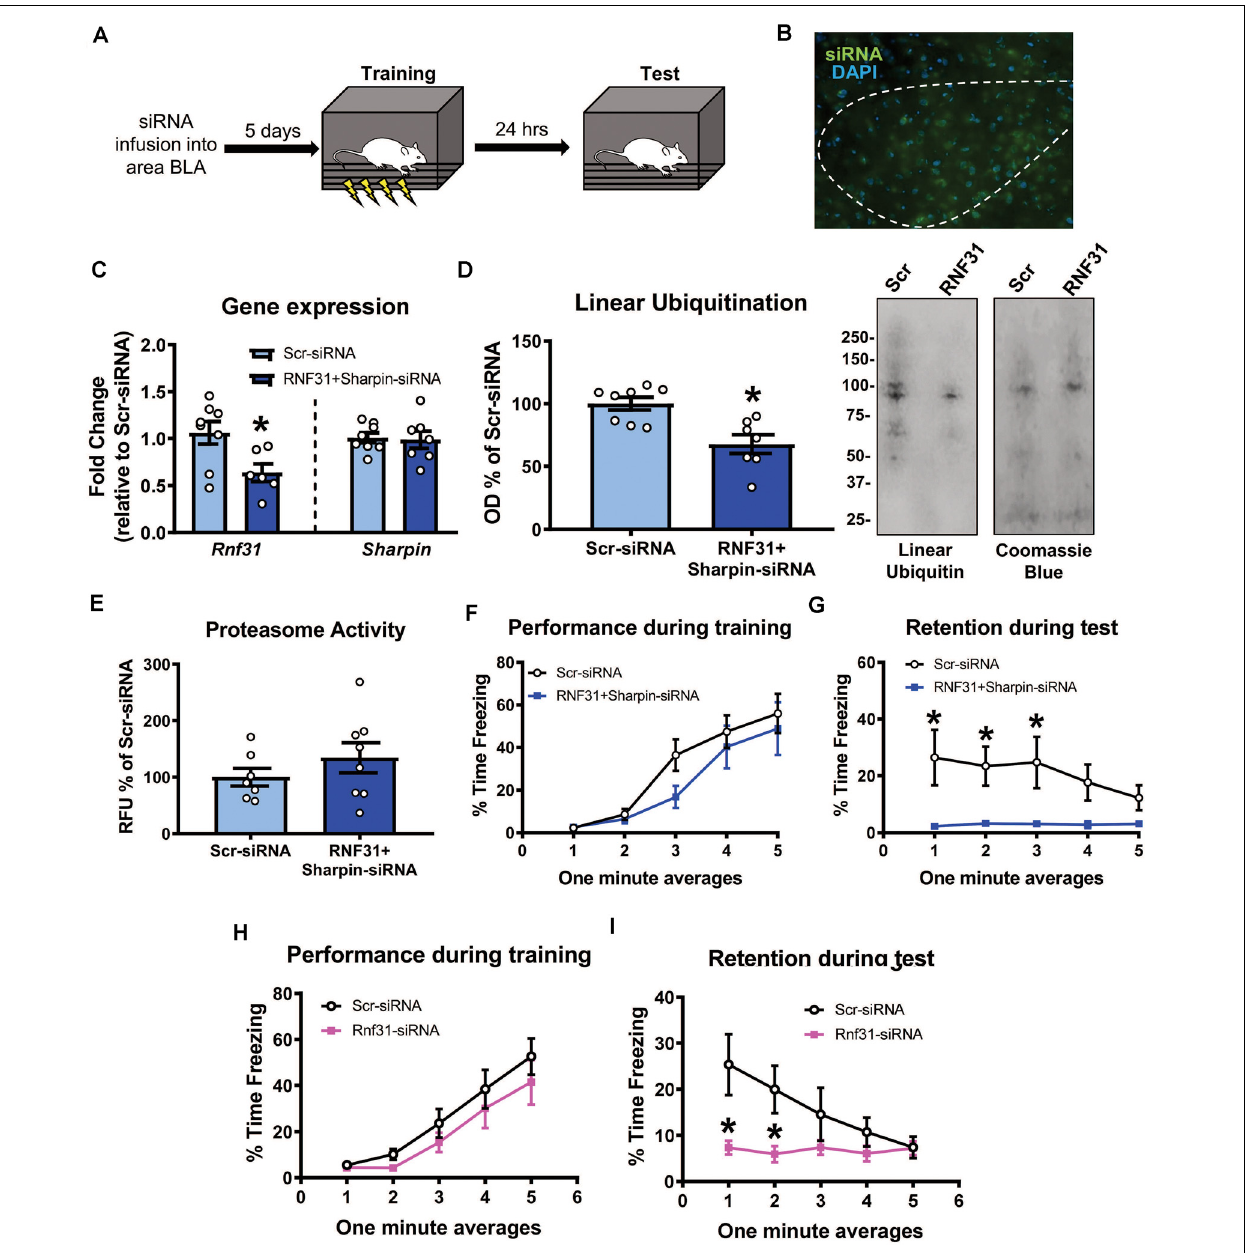
FIGURE 5 | In vivo siRNA-mediated knockdown of linear polyubiquitination in the amygdala impairs fear memory in both males and females. (A) Male rats received stereotaxic injections of Accell siRNAs targeting Rnf31 and Sharpin 5 days prior to contextual fear conditioning. They were tested for memory to the training context 24 h after training. (B) Expression of green Accell siRNA in amygdala 5 days after infusion. (C–E) Successful knockdown of Rnf31 , but not Sharpin , expression in the amygdala (C) , which reduced baseline linear ubiquitination levels (D) without altering proteasome activity (E) . (F,G) Knockdown of Rnf31 did not alter performance during the fear conditioning task (F) but impaired memory the following day (G) . (H,I) Knockdown of Rnf31 in female rats did not alter performance during the fear conditioning task (H) but impaired memory the following day (I) . All western blots were normalized to Coomassie blue stain. N = 7–8 per group for males, 8–9 per group for females. * P < 0.05 from